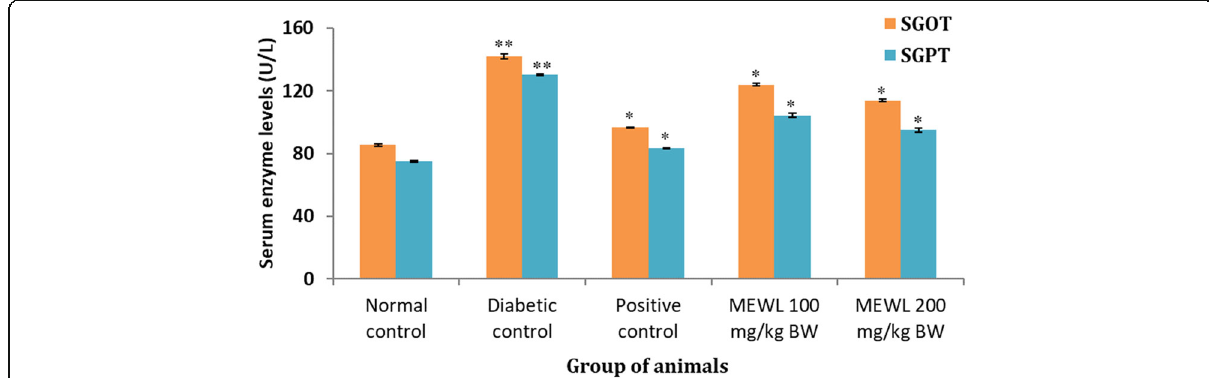
Fig. 5 Effect of MEWL treatment on serum SGPT and SGOT levels in diabetic mice. All data are expressed as mean ± SD (n; number of mice = 5). Here “ ** ” indicates p < 0.01 vs normal control mice and “ * ” indicates p < 0.01 vs diabetic control